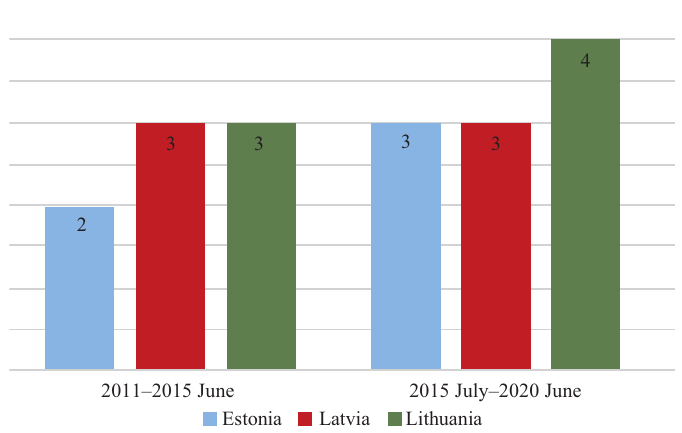
Figure 1. The most significant official bilateral visits (source: created by author)